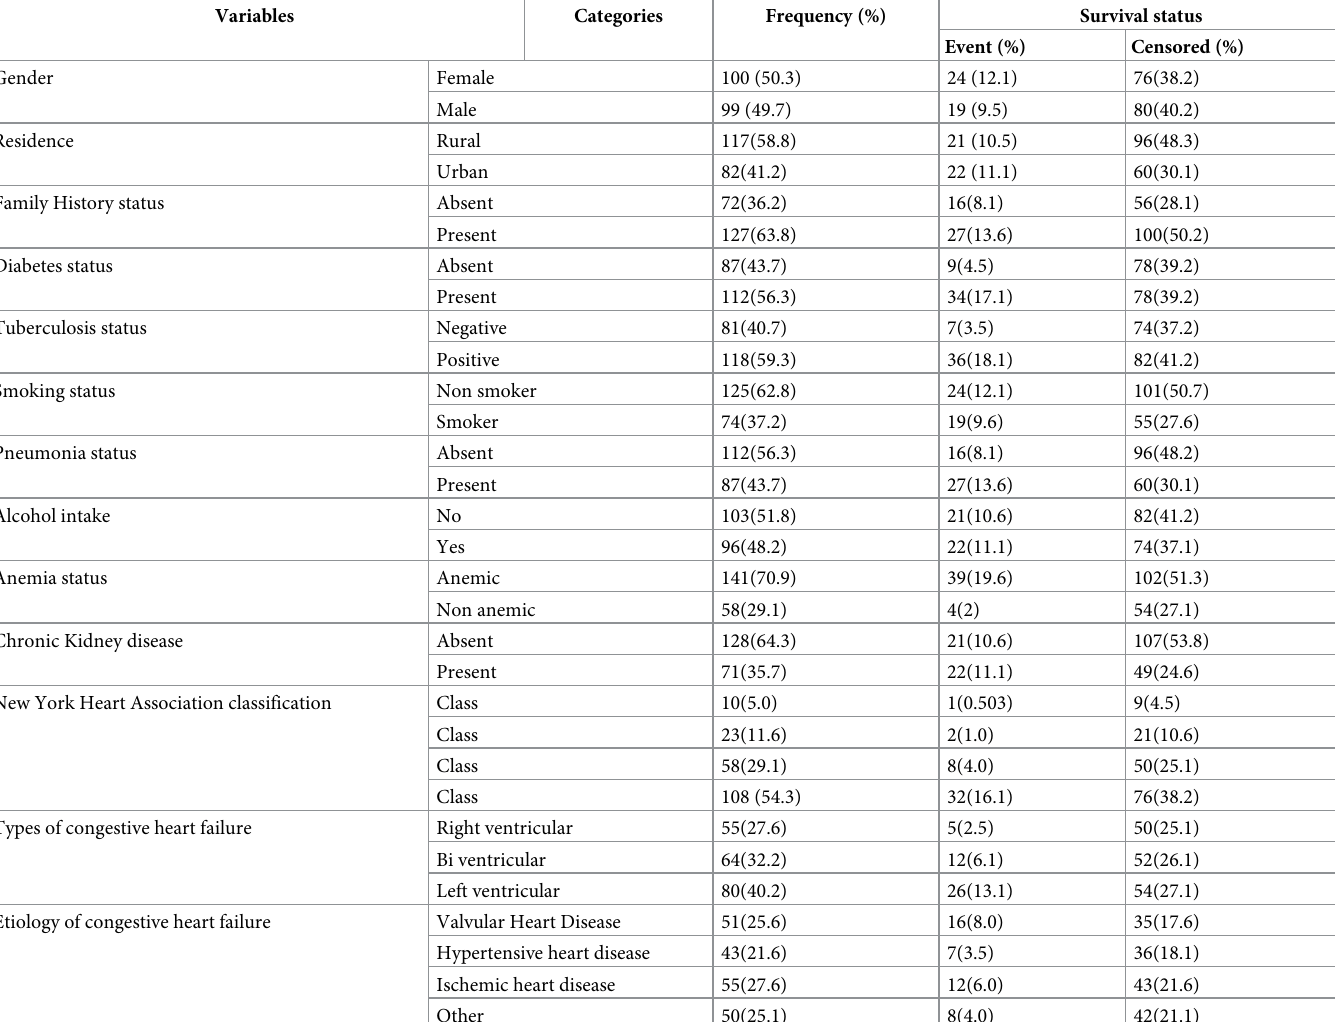
Table 1. Summary statistics for baseline characteristics of CHF patients treated at Arba Minch General Hospital from January 2017 to December